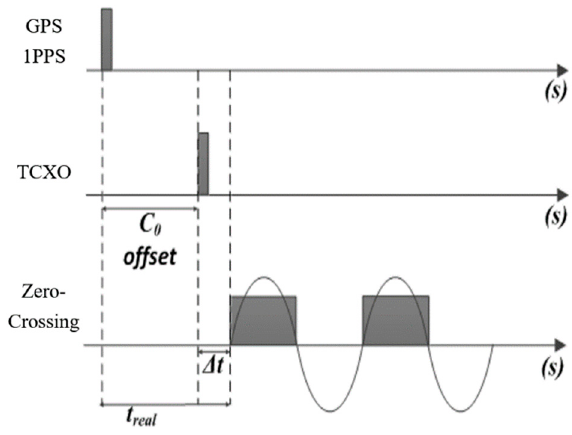
Figure 5. Calculation of compensation value.